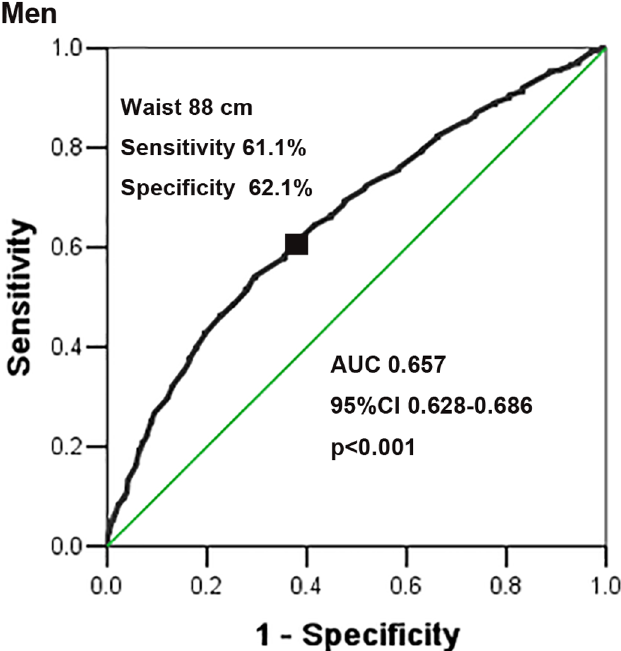
Fig 2. ROC curve of waist circumference to detect the existence of at least two other components of MetS in Kazakhs based on the JIS (2009) in men.